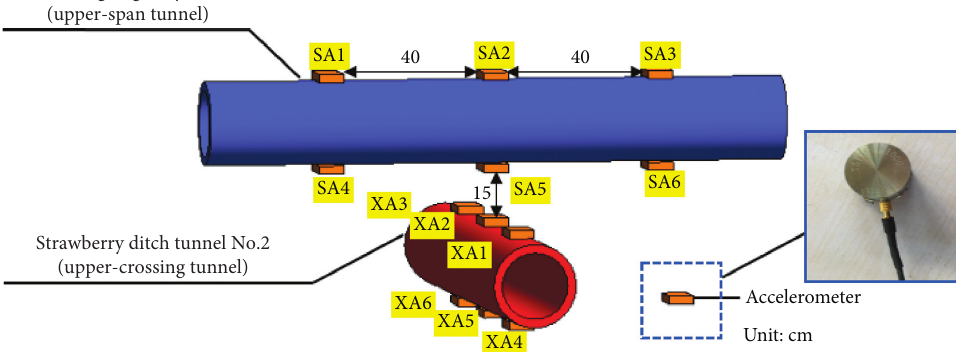
Figure 4: Arrangement of the accelerometers.